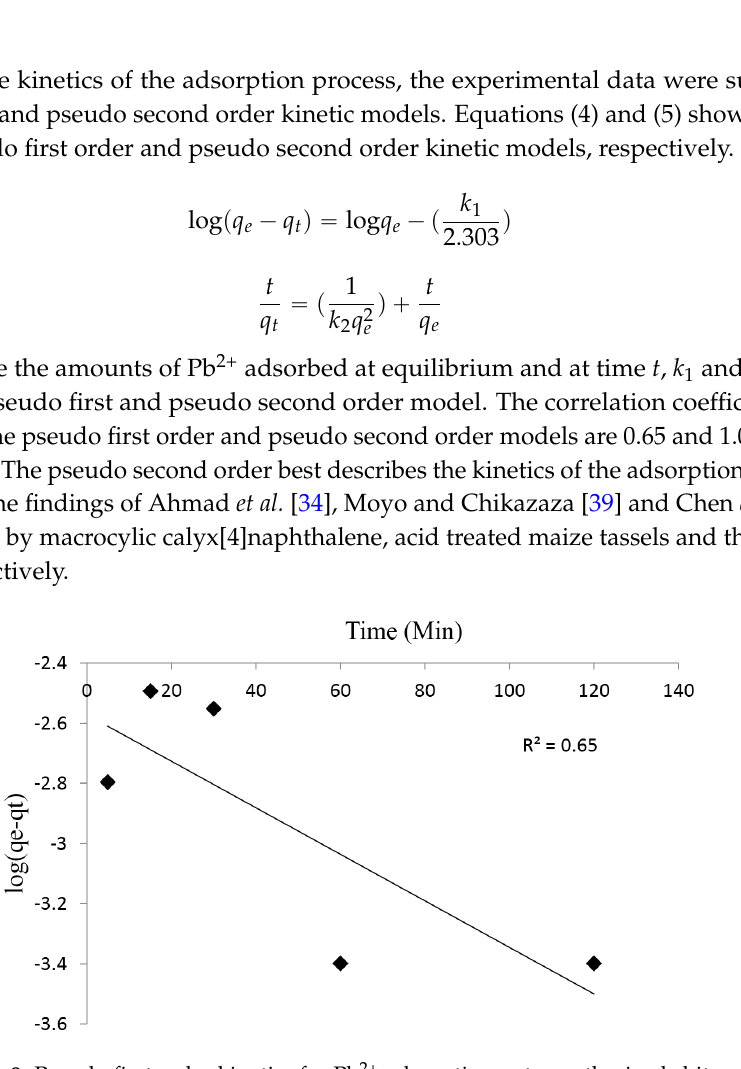
Figure 9. Pseudo first order kinetics for Pb 2+ adsorption onto synthesized